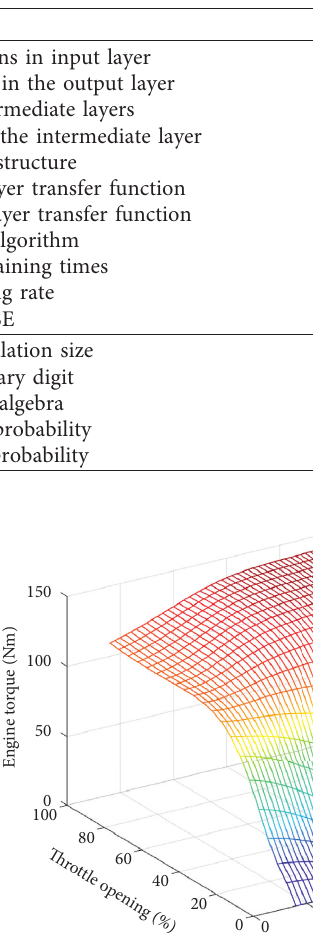
Table 3: Structure and parameters of